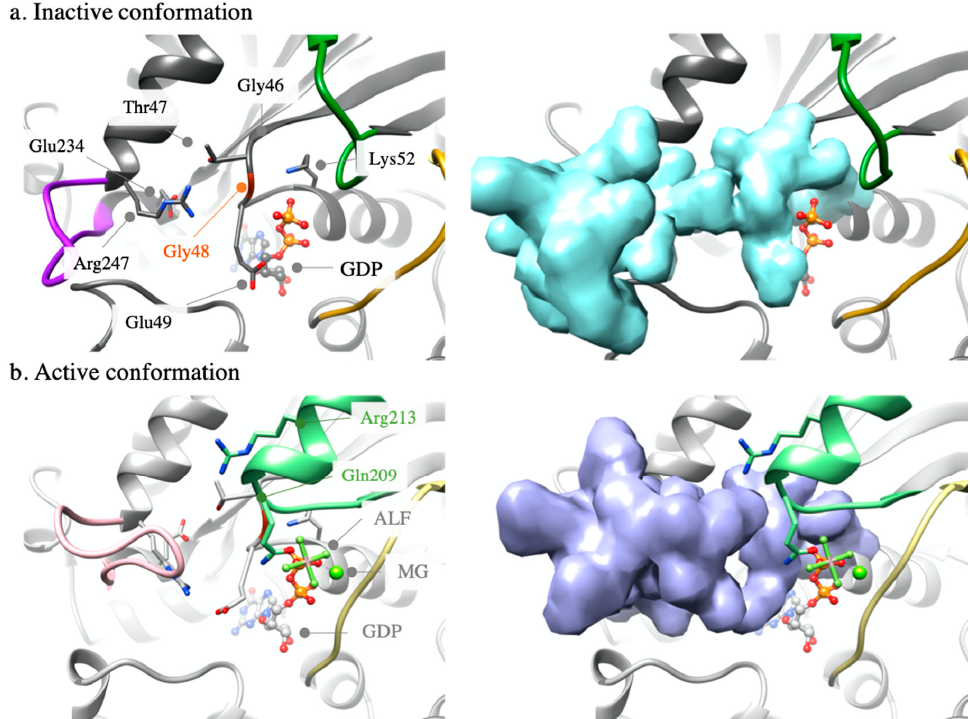
Figure 2. Inactive and active conformations. Residues are shown in sticks, ligands in ball-and-sticks and magnesium in sphere representations, respectively. For clarity, residues name in the active conformation (PDB ID 3ah8) [8] ( b ) that are already named in the inactive one ( a ) are not shown (PDB ID 3ohm) [7]. The right part of ( a , b ) represent the surface of the residues 46–52 and 234–247 to show the packing difference between the active and inactive conformations. To clarify, SW-II is not in surface representation. SW-I is in yellow/goldenrod, SW-II in light-green/dark-green, and SW-III in pink/purple. These results indicate that mutation p.Gly48Leu is favorable to the structural stability of G α q both in the active and inactive conformations. However, the e ff ect is more pronounced in the active form (1.8 ± 0.7 kcal / mol) than in the inactive one (0.4 kcal / mol). Analyses of the mutant